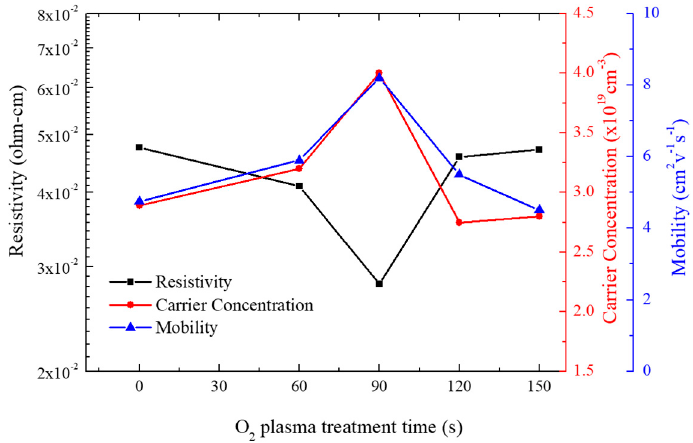
Figure 6. The electrical resistivity, carrier concentration and mobility as a function of O 2 plasma treatment time for the Zn 0.6 Sn 0.4 O thin films.